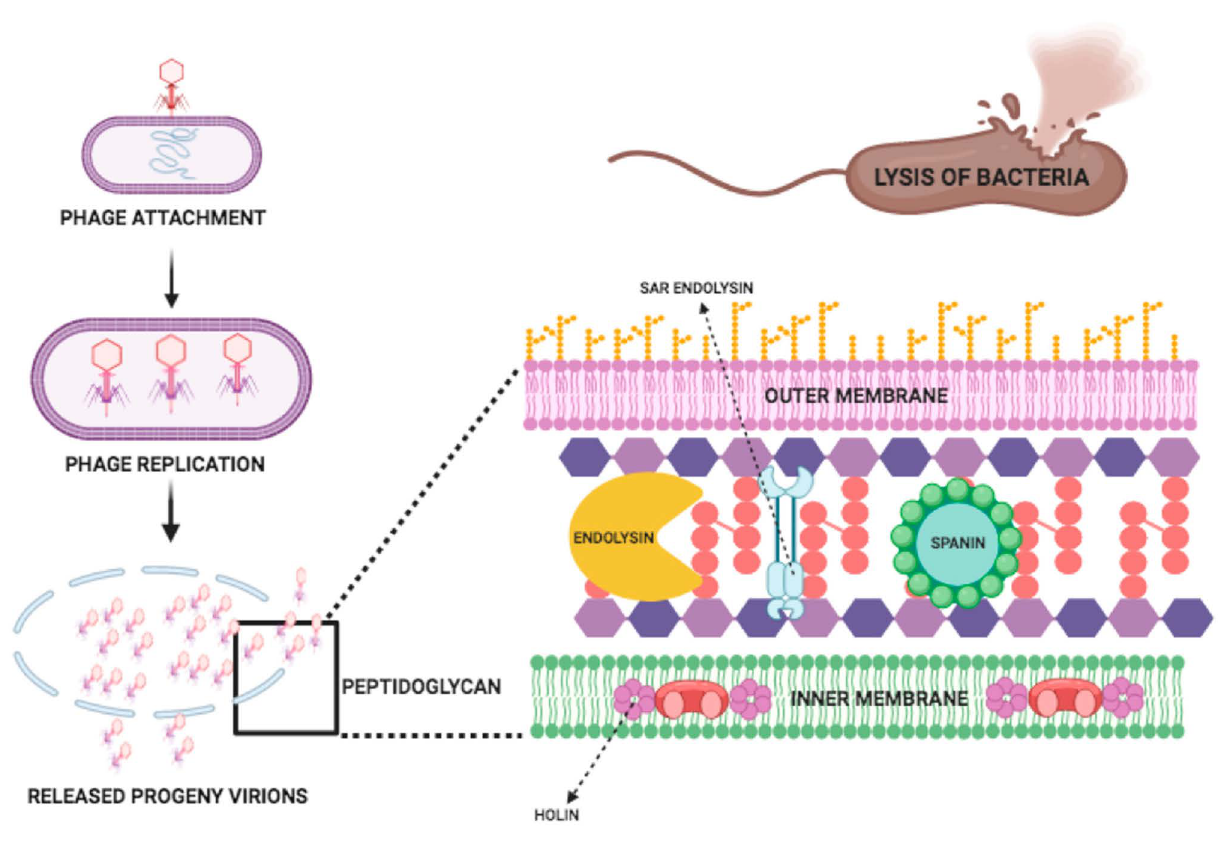
Figure 4. Mechanism of action of